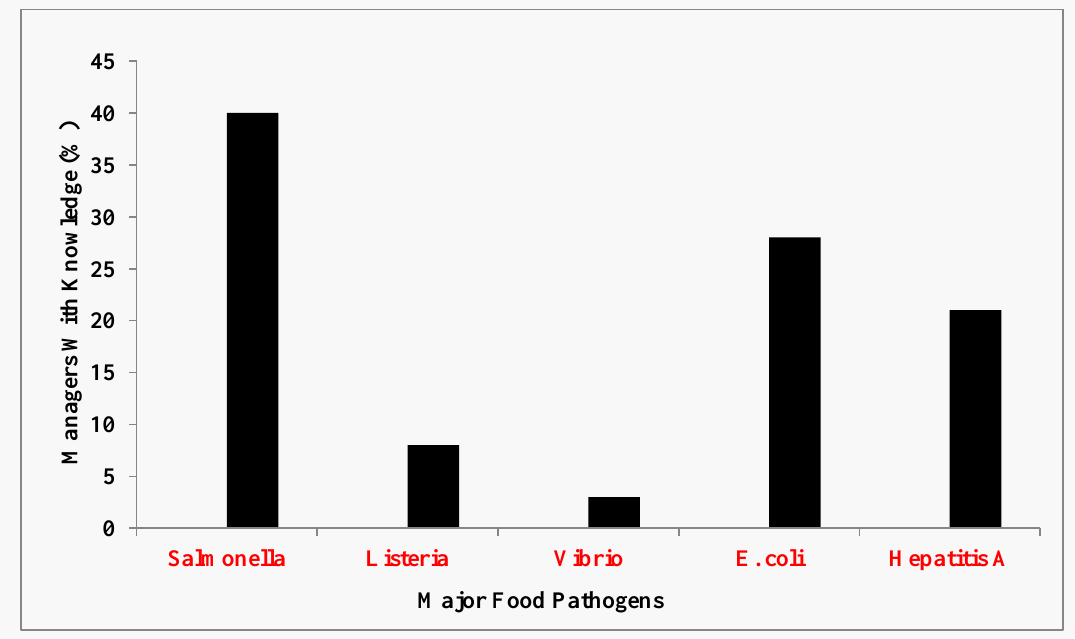
Figure 4. Managers’ knowledge of major food